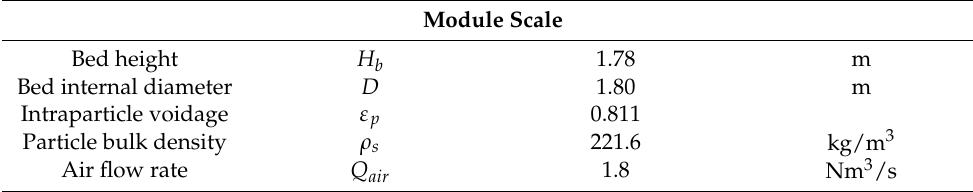
Table 8. Industrial module